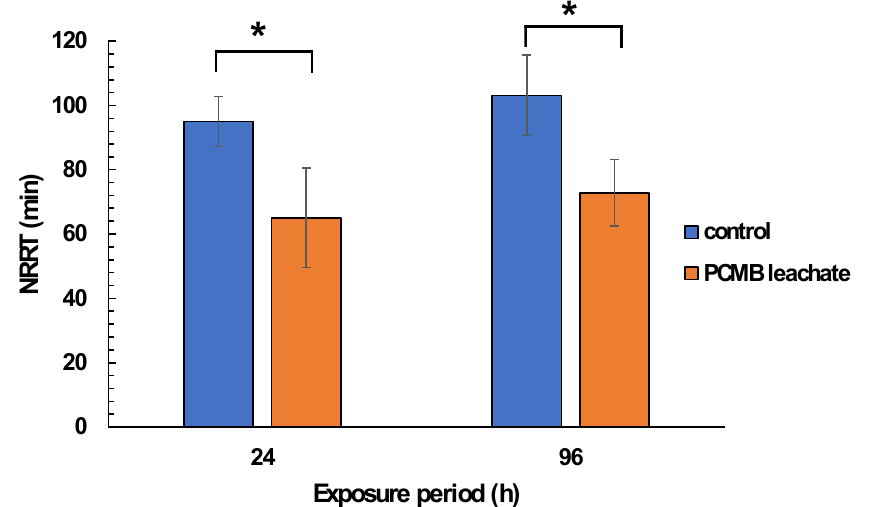
Figure 3. Lysosomal membrane stability (in terms of NRRT values) in hemocytes of mussels exposed to PCMB-ASW for 96 h. The results (expressed as min) are mean ± SDs for 10 individuals in each case. Asterisks (*) indicate significant difference from the respective control (Mann–Whitney u-test, p < 0.05).